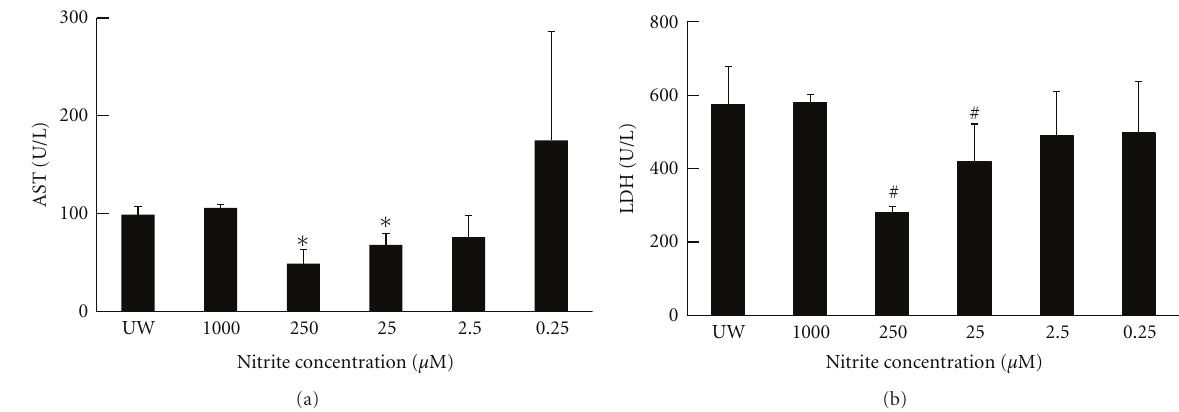
Figure 1: Nitrite-supplemented UW solution decreased hepatic graft enzyme release. UW solution supplemented with anion nitrite decreased hepatic graft enzyme release during 24 hours of cold ischemia. Solutions of 250 (AST—68 ± 12; LDH—420 ± 102) and 25 (AST— 38 ± 4; LDH—280 ± 17) µ M anion nitrite resulted in the greatest reduction. Data are expressed as mean ± SE. # P < 0 . 05 for corresponding measurements.